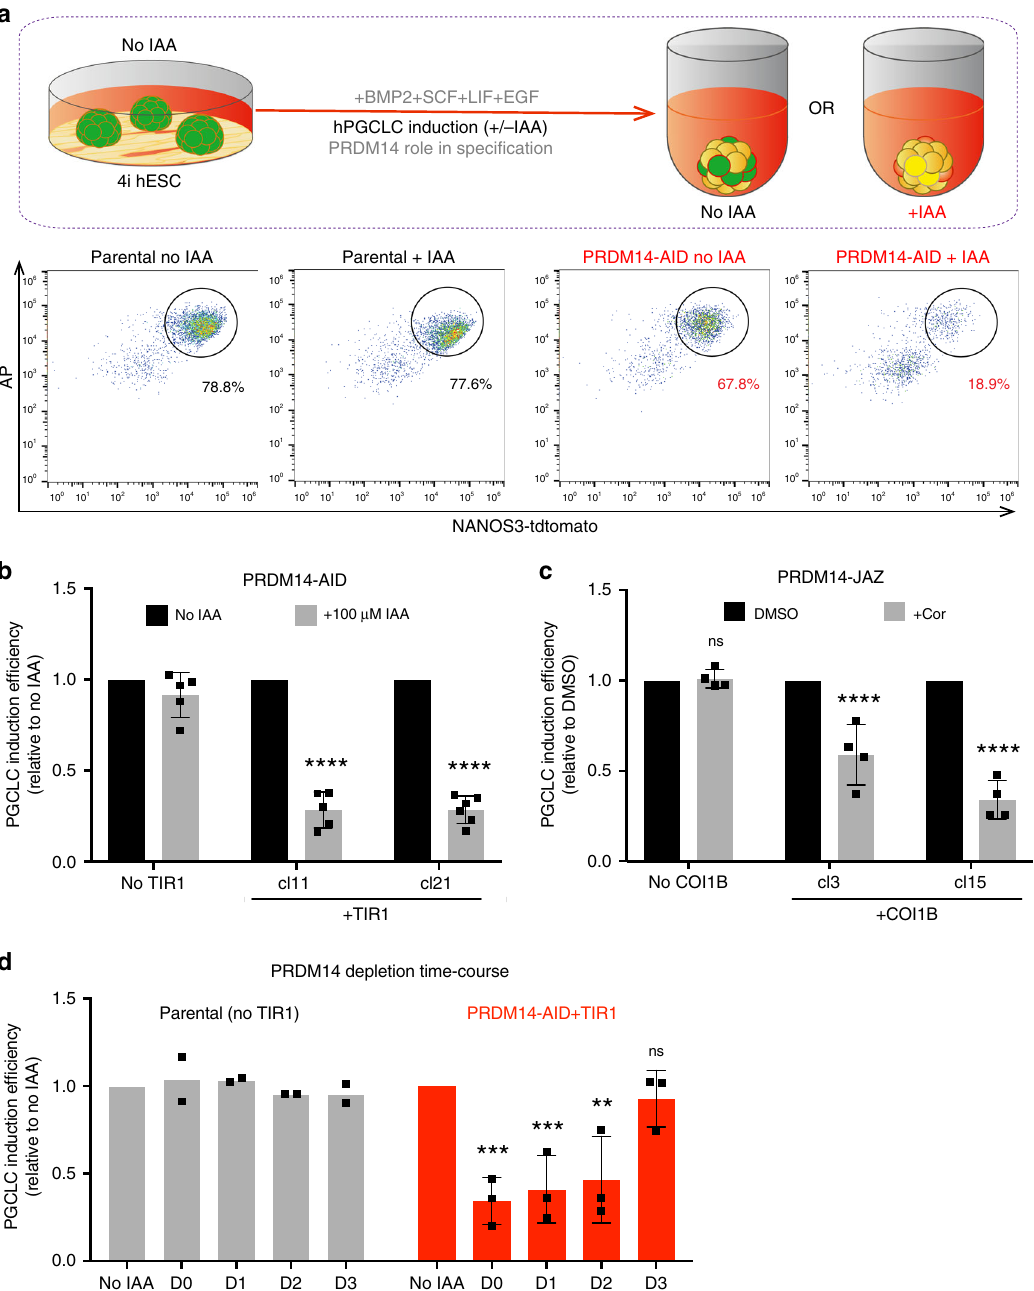
Fig. 4 PRDM14 depletion using AID or JAZ degrons reduces hPGCLC speci fi cation ef fi ciency. a Experimental design and representative fl ow cytometry plots showing reduced hPGCLC induction in hormone-sensitive clones, but not in the parental control. hPGCLCs were de fi ned as NANOS3-tdTomato + AP + cells. b Quanti fi cation of fl ow cytometry results for PRDM14-AID-Venus hPGCLCs induced with or without IAA (100 μ M). The induction ef fi ciency of untreated cells ( “ no IAA ” ) was set to 1. Data show mean ± SD for n = 5 for cl11 and “ no TIR1 ” control and n = 6 for cl21, ns not signi fi cant ( P = 0.1308), **** P < 0.0001 (Two-way ANOVA followed by Sidak ’ s multiple comparison test). c Quanti fi cation of fl ow cytometry results for PRDM14-JAZ-Venus hPGCLCs. The induction ef fi ciency of untreated cells ( “ no Cor ” ) was set to 1. Data show mean ± SD for n = 4 independent experiments per clone, ns not signi fi cant ( P = 0.9979), **** P < 0.0001 (Two-way ANOVA followed by Sidak ’ s multiple comparison test). d Time-course of PRDM14 depletion. IAA (500 μ M) was added on indicated days of hPGCLC induction from PRDM14-AID-Venus clones. Note that IAA was not washed off until the end of differentiation (D4), when hPGCLC induction ef fi ciency was assessed by fl ow cytometry. Data show mean ± SD of n = 3 for PRDM14-AID or mean of n = 2 for “ no TIR1 ” control. Statistical signi fi cance was analysed by two-way ANOVA followed by Sidak ’ s multiple comparison test. For PRDM14-AID: no IAA vs. D0 ***( P = 0.0003), no IAA vs. D1 ***( P = 0.0008), no IAA vs. D2 **( P = 0.0018), no IAA vs. D3 ns (not signi fi cant, P = 0.9614); for “ no TIR1 ” : all ns not signi fi cant ( P >